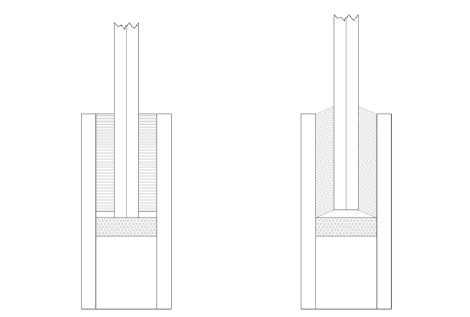
Figure 6: Left: Sketch of the connection detail for the glass panes at the lower and upper edge. The glass panes are glued into a steel clamp - which is fixed to the edges of the roof and the box girder – with structural glazing material. Right: The glass can execute relative movements to the steel parts, at the same time it is partly clamped. Basic design idea II: In-plane action of the roof can activate an effective three- dimensional load